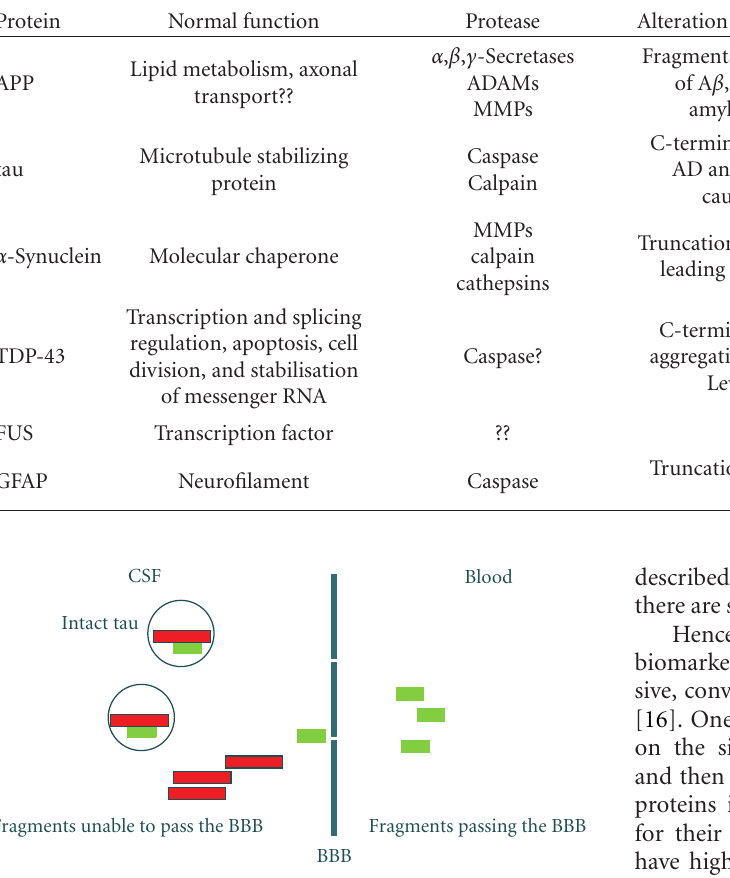
Figure 2: Schematic illustration of proteins present in the CSF, and the possibility that small fragments can